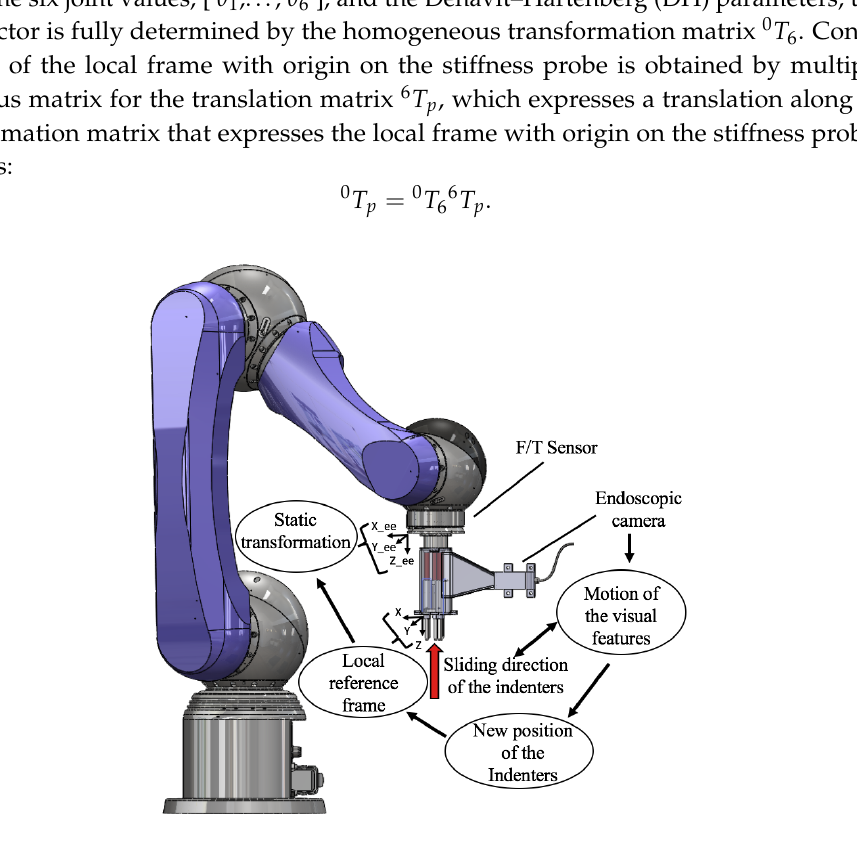
Figure 4. Stiffness probe fixed at the tip of the robotic arm: the interaction with external objects generates the sliding of the indenters. Hence, the visual features change their positions in the camera’s image. The correlation between the indenters and the features allows for measuring the new positions of the indenters in the local reference frame. A static transformation maps the new positions of the indenters from the local frame into the robot kinematic